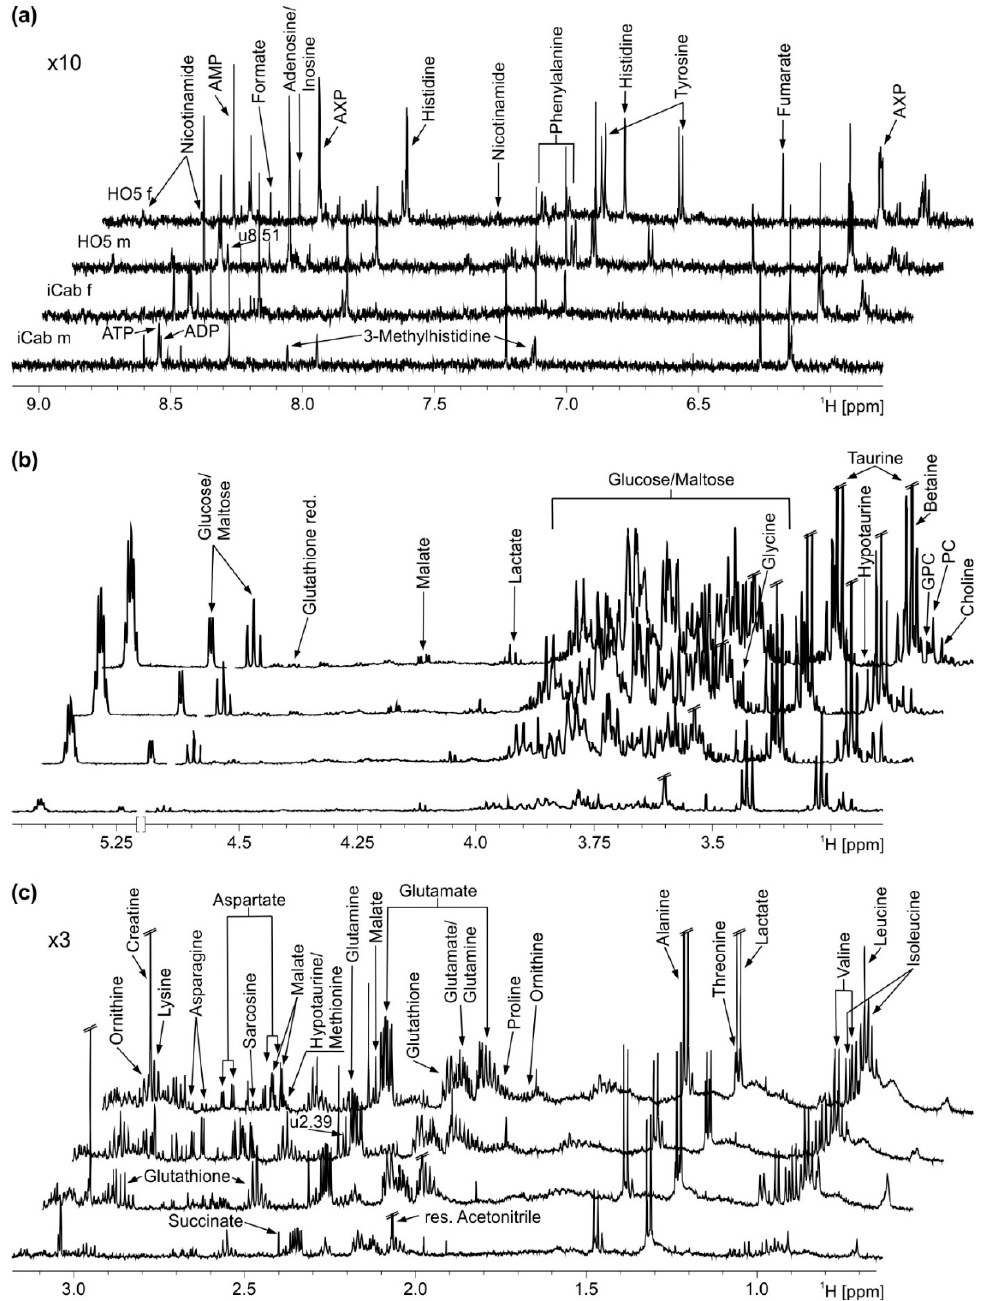
Figure 1. Representative 1 H NMR spectra before normalization with annotations for all identified metabolites. ( a ) Aromatic region. ( b ) Sugar region. ( c ) Aliphatic region. From top to bottom: HO5 female (f), HO5 male (m), iCab female, iCab male. AXP: AMP, ADP and ATP, GPC: Glycerophosphocholine, PC: Phosphorylcholine.